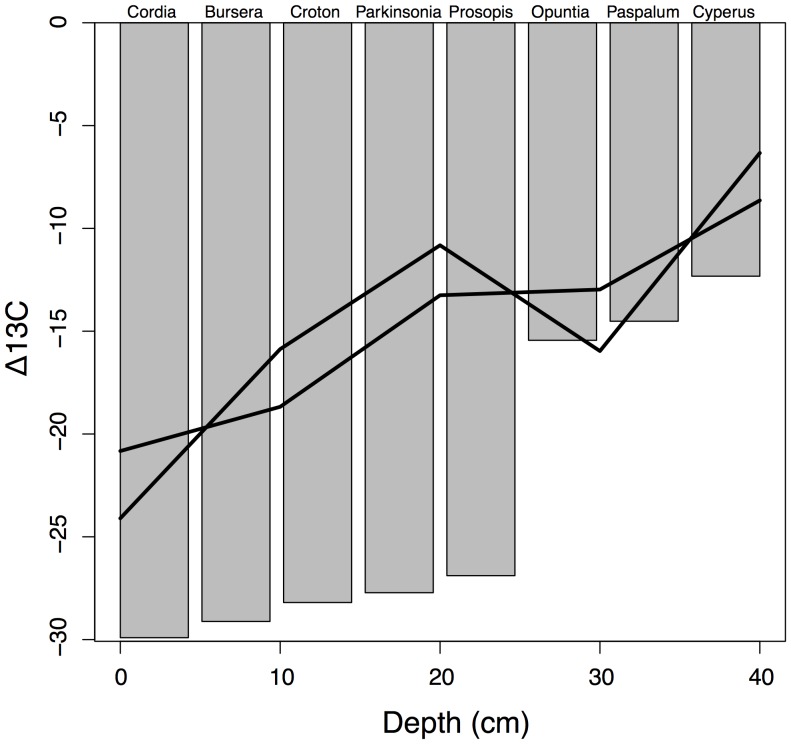
Carbon isotope signatures (δ13C values) of soils at increasingly greater depths in two soil pits (Gardner and El Caco) on Española Island, Galapagos. Radiocarbon dating indicated that depths of 40 cm are approximately 500 years BP; therefore, samples below the 40 cm depth are grouped to show pre-disturbance averages. Points are δ13C values of the island’s dominant woody plants (Bursera, Cordia, Croton, Parkinsonia, Prosopis) and herbaceous plants (Cyperus and Paspalum) as well as cactus (Opuntia) (averaged across 10 samples of each, with standard errors for all means too miniscule to be evident in this graphic).